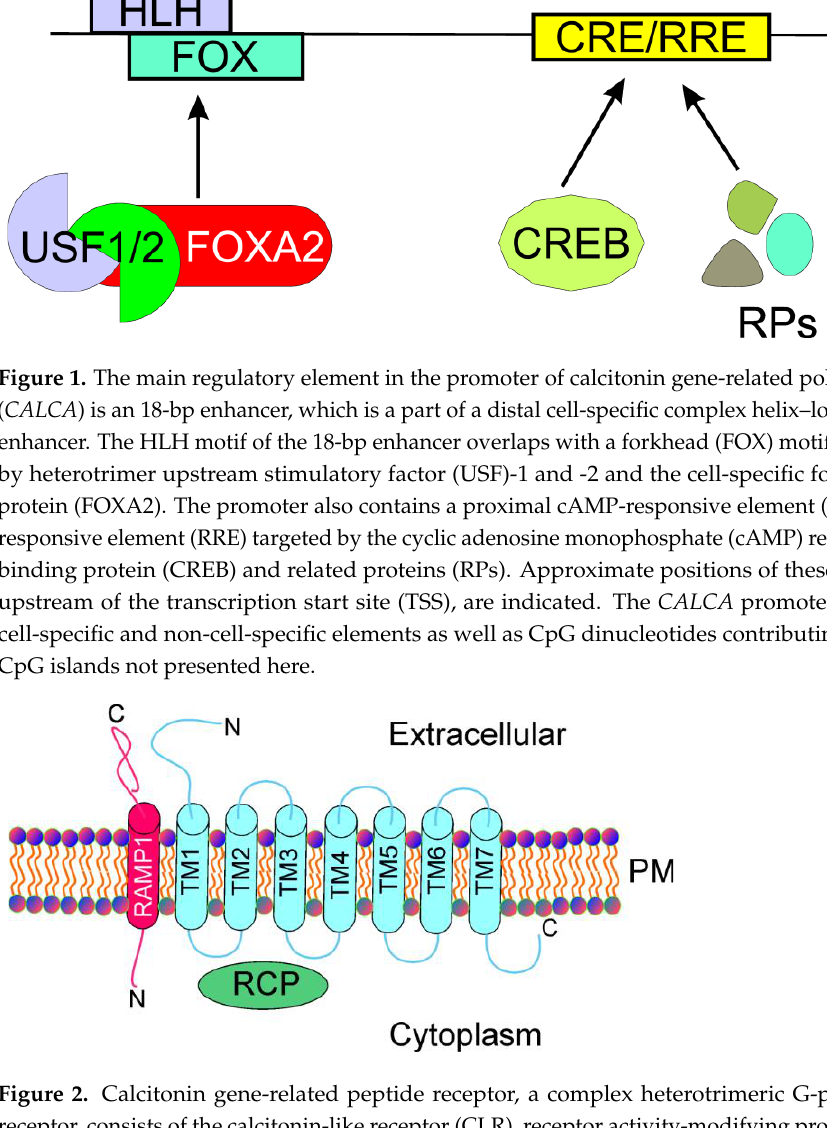
Figure 2. Calcitonin gene-related peptide receptor, a complex heterotrimeric G-protein-coupled re- ceptor, consists of the calcitonin-like receptor (CLR), receptor activity-modifying protein 1 (RAMP1), and a small receptor component protein (RCP). CLR includes 7 transmembrane proteins (TM1 – 7), whereas RAMP1 is a single transmembrane protein. PM — plasma membrane. play a role in splice site selection and is, therefore, important for CGRP